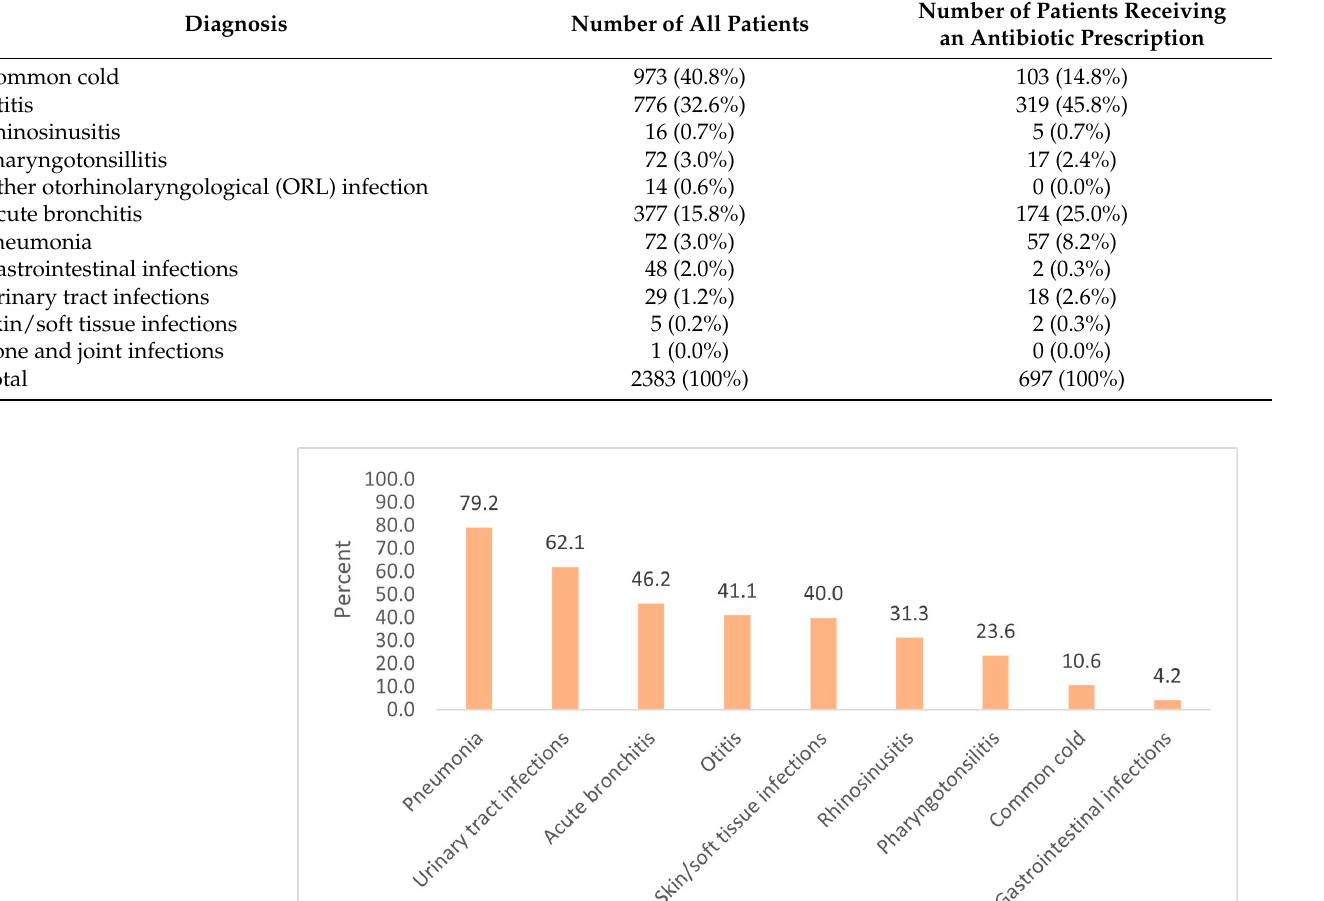
Table 3. Major types of infections for all recruited patients and patients treated with antibiotics.